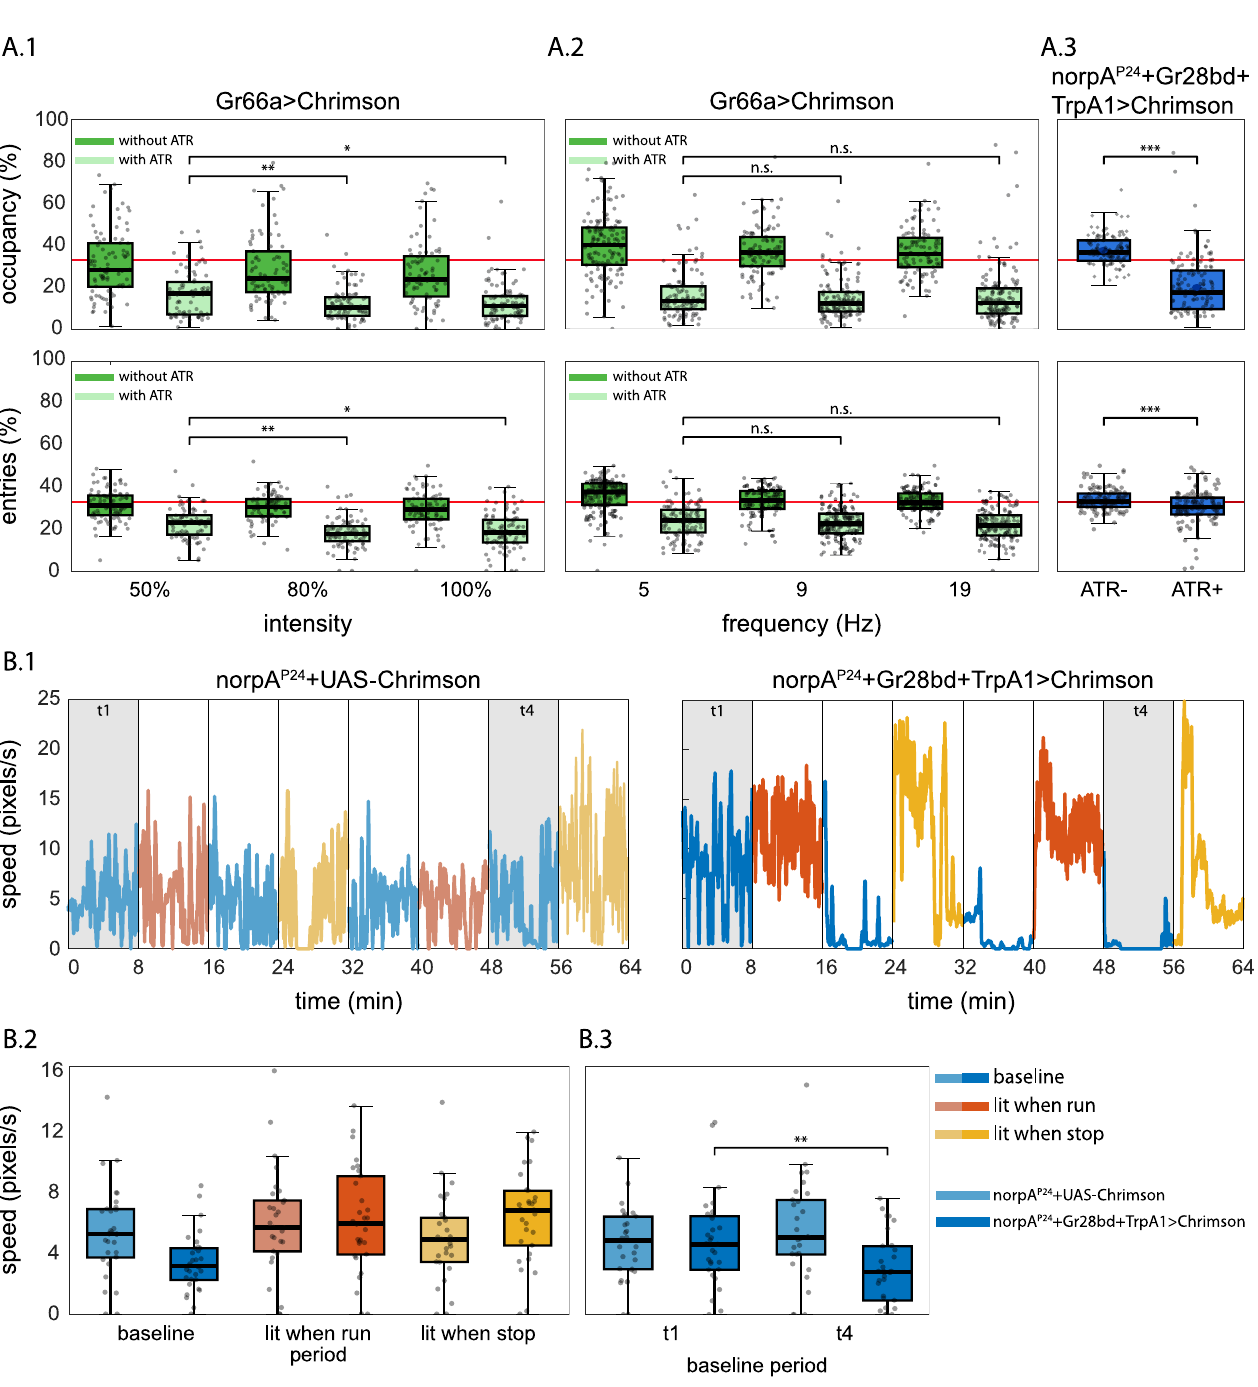
Fig 6. Optogenetic closed-loop experiments with MARGO. A.1) Top: Fraction of time spent in the arm of a Y-maze which was triggered to optogenetically stimulate flies expressing CsChrimson in bitter taste receptor neurons. Bottom: Portion of arm entries into the reinforced arm. Light green boxes are control flies not fed ATR; dark green experimental flies are fed ATR. Red line indicates chance rates. Individual points are flies. Even at the lowest intensity (50%), flies show a robust avoidance of the reinforced arm in a Y-Maze. Increasing light intensity (x-axis) further decreases (slightly) the lit arm occupancy time and the lit arm entries even further. Here and elsewhere � :p < 0.05, �� :p < 0.01, ��� :p < 0.001. A.2) As in A.1, but varying the frequency of the optogenetic stimulation. Frequency had little effect on the occupancy or rate of entry into the reinforced arm. A.3) Blind norpA P24 ;Gr28bd+TrpA1 > Chrimson flies, expressing Chrimson in heat-sensitive neurons, also show decreased occupancy in the lit arm, whereas the fraction of entries into the lit arm appears unchanged compared to control flies not fed ATR. B.1) Example walking speed traces of an individual fly in circular arenas stimulated upon when above or below (depending on trial period) a speed threshold 4 px/s. Line color indicates which reinforcement paradigm was used in each period. Initial (t1) and final (t4)